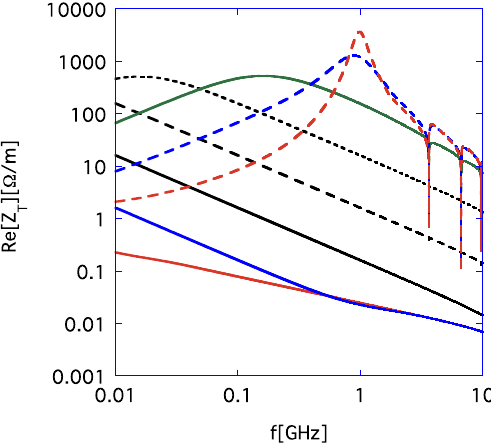
FIG. 6. (Color) The thickness dependence of the transverse impedance of the insert for the relativistic beam case. The red, the blue, the black, the black dashed, the black dot, the green, the blue dashed, and the red dashed lines represent the cases that thickness t is equal to 100 (cid:13) m , 10 (cid:13) m , 1 (cid:13) m , 100 nm, 10 nm, 1 nm, 100 pm, and 10 pm, respectively. The impedance becomes proportional to f (cid:1) 1 , when the skin depth exceeds the insert thickness. The matching point is z ¼ 0